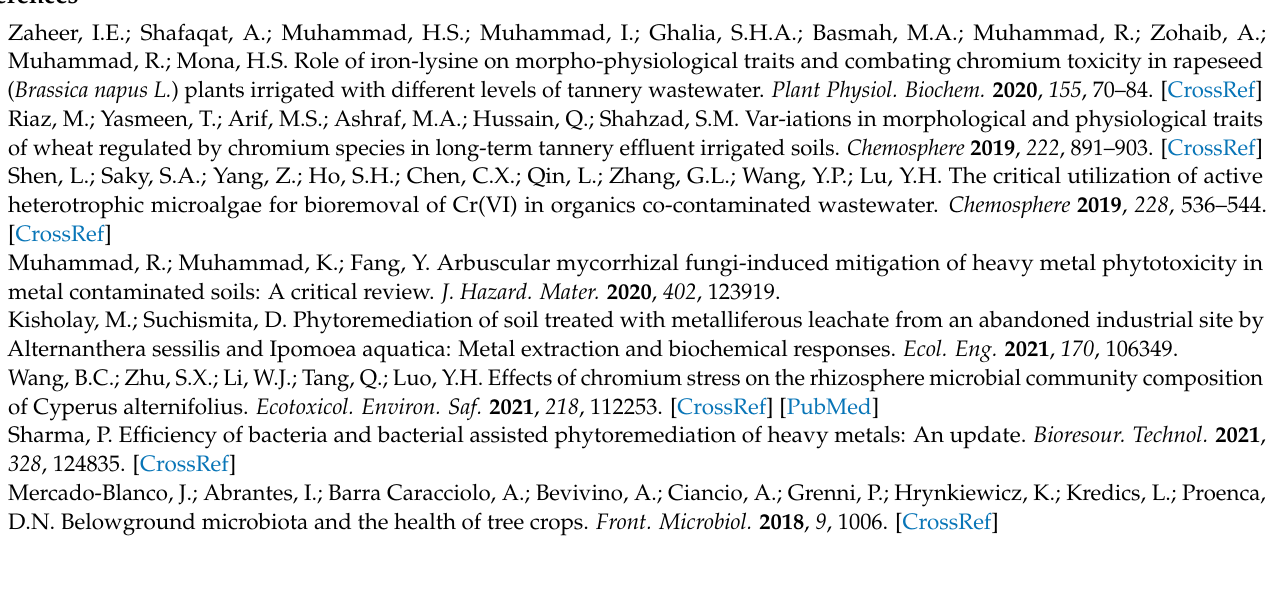
ure S1— I. tectorum pot experiment design. Table S2—Attribute table of bacterial community network under Cr stress cultivation mode. Figure S1—I. tectorum pot experiment design. Figure S2—Bacterial community dilution curve of soil sample. Figure S3—Evolution tree of rhizosphere microbial com- munity of I. tectorum. Figure S4—Collinear network